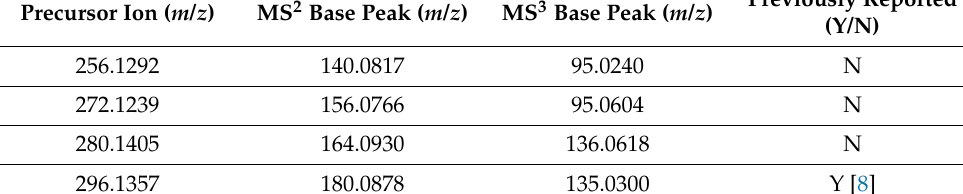
Table 1. Precursor ion ( m / z ), MS 2 and MS 3 spectra base peaks for each putative DNA adduct (MS 2 and MS 3 spectra are reported in the Supplementary Information (SI), together with the hypothe- sized structures) and presence in literature. Data were obtained analyzing DNA incubated with acetaldehyde (5